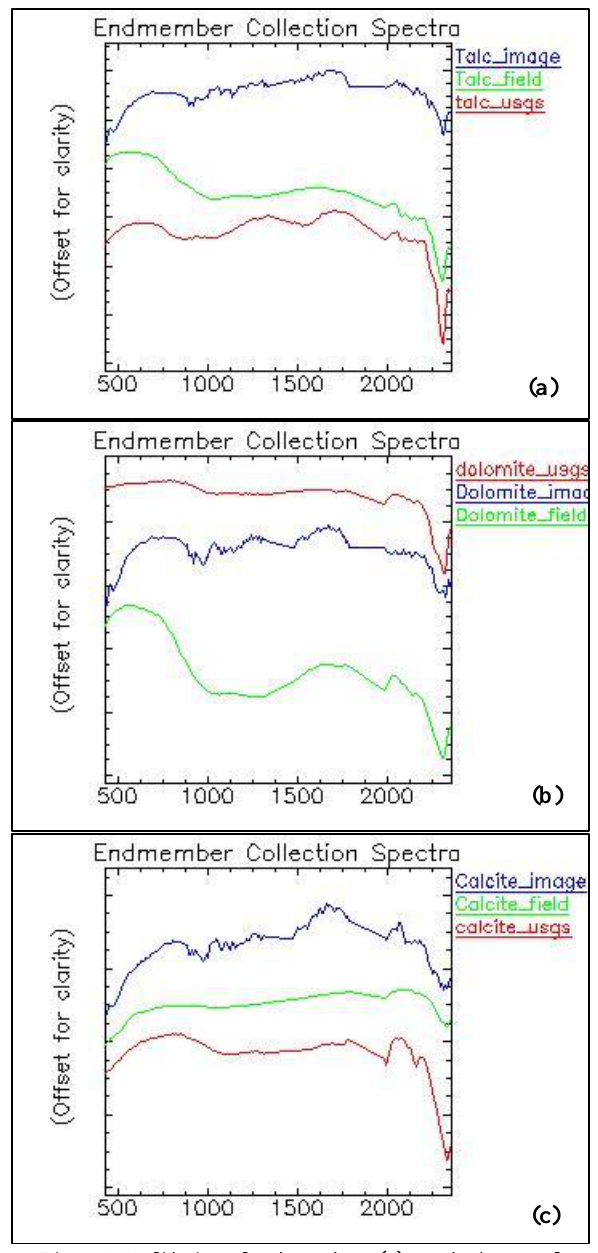
Figure 4. Validation of end members (a) matched spectral signatures of dolomite (b) matched spectral signatures of talc (c) matched spectral signatures of